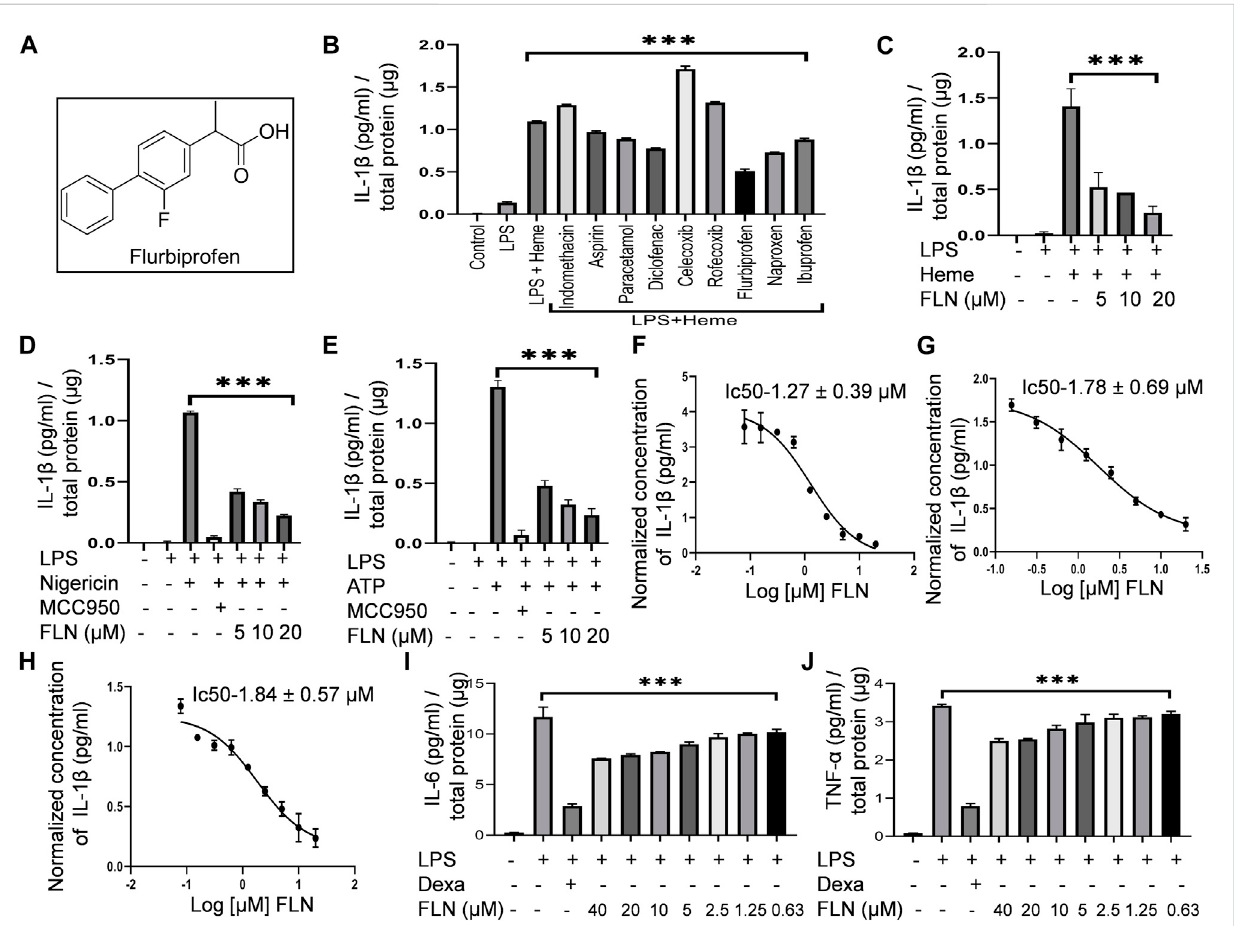
FIGURE 1 FLN( fl urbiprofen)inhibitsNLRP3in fl ammasomeactivatedagainstheme,Nigericin,andATPbyinhibitingIL-1 β levels.DifferentiatedTHP-1cellswere treated with LPS 100 ng/mL for 4 h. Drug treatment was given for 1 h at 10 μ M concentration followed by 50 μ M heme treatment for 1 h. For stimulation by ATP and Nigericin, J774A.1 cells were primed with LPS 1 μ g/mL for 5.5 h followed by FLN or MCC950 (100 nM) treatment for 1 h. ATP at 3 mM for 30 minorNigericinat10 μ Mfor1 hwasusedasasecondarysignal. (A) StructureofracemicmixtureofFlurbiprofen. (B) ScreeningofNSAIDsagainst heme-inducedNLRP3in fl ammasomebydetecting IL-1 β level inthecellularsupernatant.AnalyzingIL-1 β levelsinthesupernatantof (C) hemestimulated THP-1cellsandin (D) Nigericinand (E) ATPstimulatedJ774A.1cells.IC50ofFLNforIL-1 β against (F) hemeinducedTHP-1cells,and (G) Nigericin,and (H) ATP induced J774A.1 cells. FLN inhibits in fl ammation caused by IL-6 and TNF- α . J774A.1 cells were treated with 1 μ g/mL LPS for 24 h following pretreatment of the drug or dexamethasone (10 μ M) for 1 h. Levels of (I) IL-6 & (J) TNF- α were analyzed in supernatant through ELISA. MCC950 and Dexamethasone were taken as standard inhibitors. The data presented here is the mean of three independent experiments ±SD. Statistical signi fi cance was measured in GraphPad prism 8 by using one-way ANOVA and Bonferroni test as post hoc . p < 0.05 was taken as signi fi cant. p values *** p < 0.001, ** p < 0.01, * p <